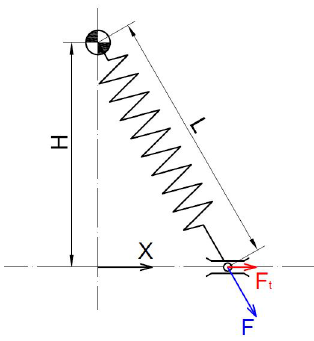
Figure 21. Schematic representation of a bi-stable mechanism with a single